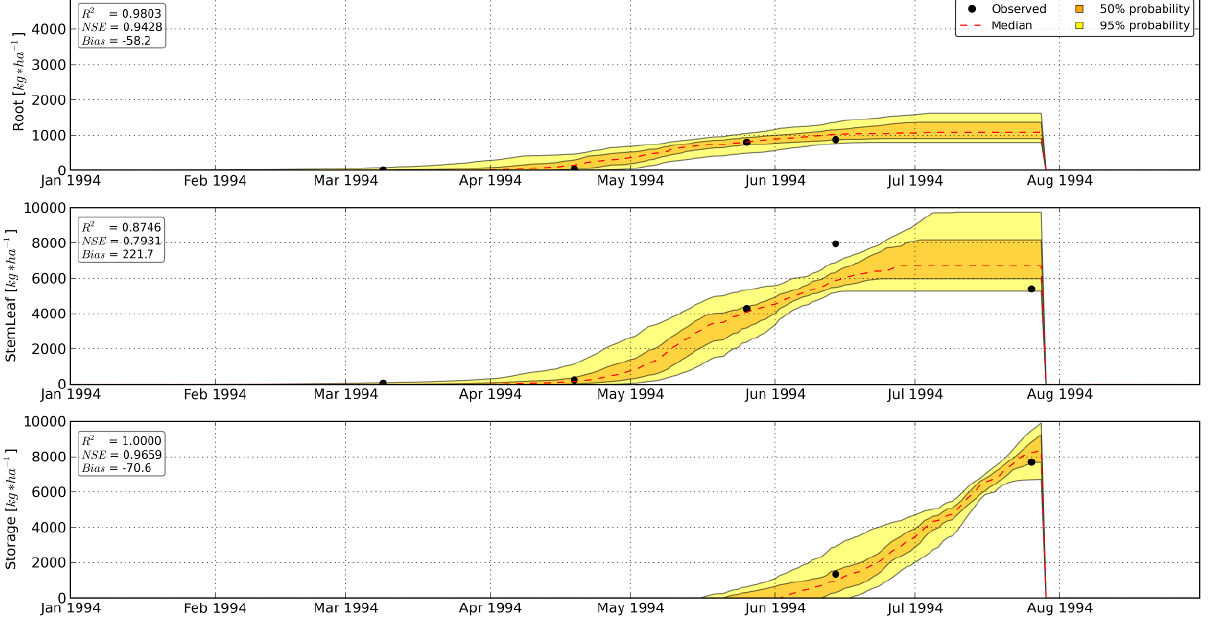
Fig. 3. Probabilistic time series for the simulation of plant dry matter with behavioural (NSE > 0, bias < ± 500kgha − 1 plant dry matter and R 2 > 0 . 3) CMF–PMF model runs at site 1. Inserts: the likelihood functions quantify the median of the prediction range. Note differences in the scale of the y-axis.